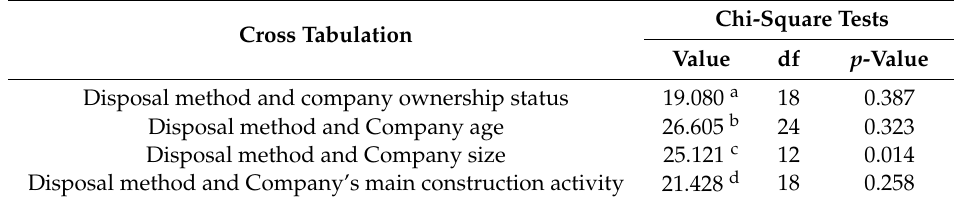
Table 6. Association between methods and company’s